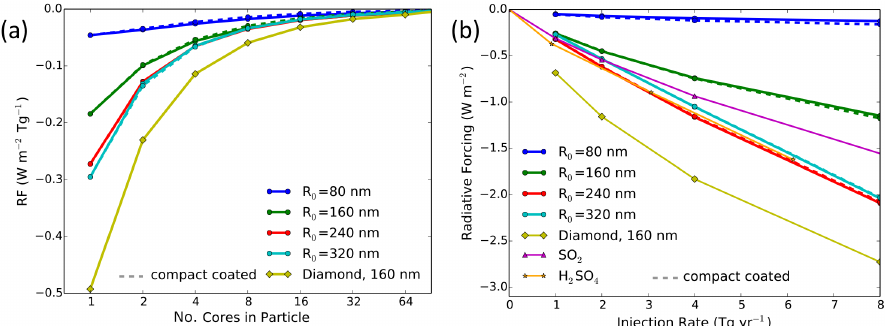
Figure 7. Shortwave globally averaged clear-sky radiative forcing per teragram burden (Wm − 2 Tg − 1 ) of alumina or diamond particles as a function of the number of monomer cores per fractal particle (panel a ). Calculated globally averaged shortwave radiative forcing as a function of injection rate for geoengineering scenarios (panel b ) for annual average cloud-free conditions. The dashed lines represent simulations in which the coated alumina particles are assumed to become more compact in shape.